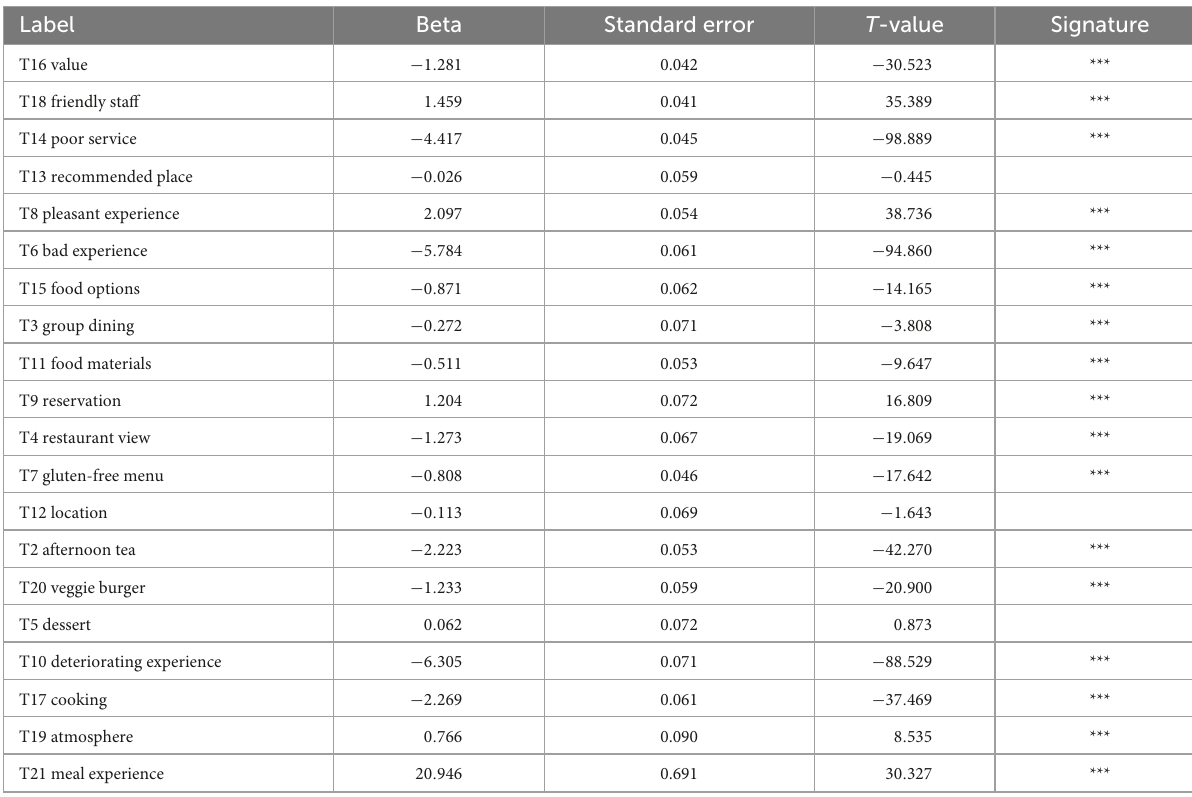
TABLE 3 Regression results to predict restaurant